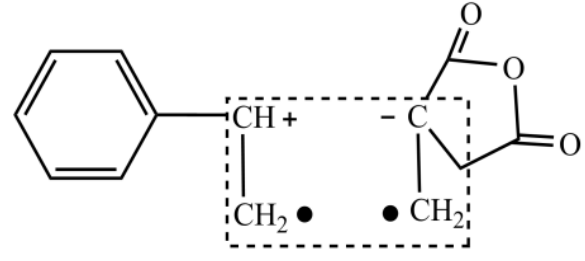
Figure 3. CTC Structure Formed by ITA and St.